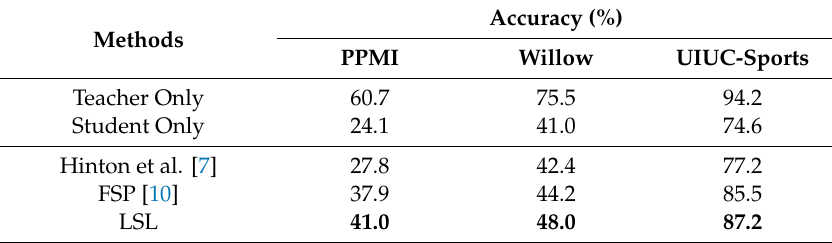
Table 8. Comparison of classification accuracy on PPMI, Willow, and UIUC-Sports datasets. In ASL, the alignment layers are deployed on Conv4, Conv5, and FC1 in the teacher network and Conv2, Conv3, and FC1 in the student